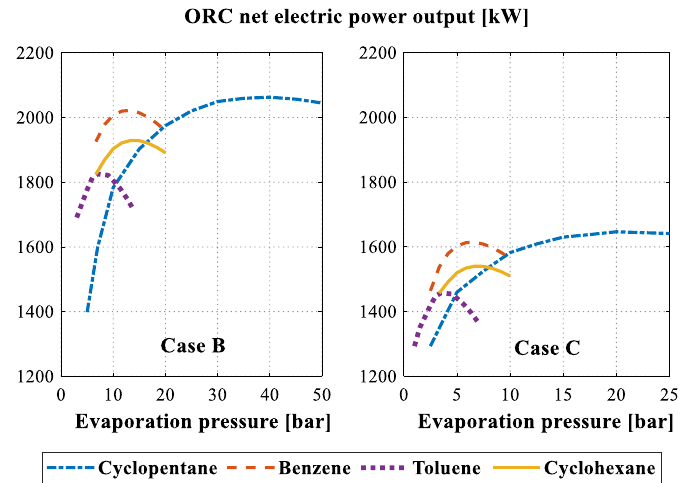
Figure 9. Sensitivity analysis results on organic fluid and IHTF design temperature: Case B and Case C layout.